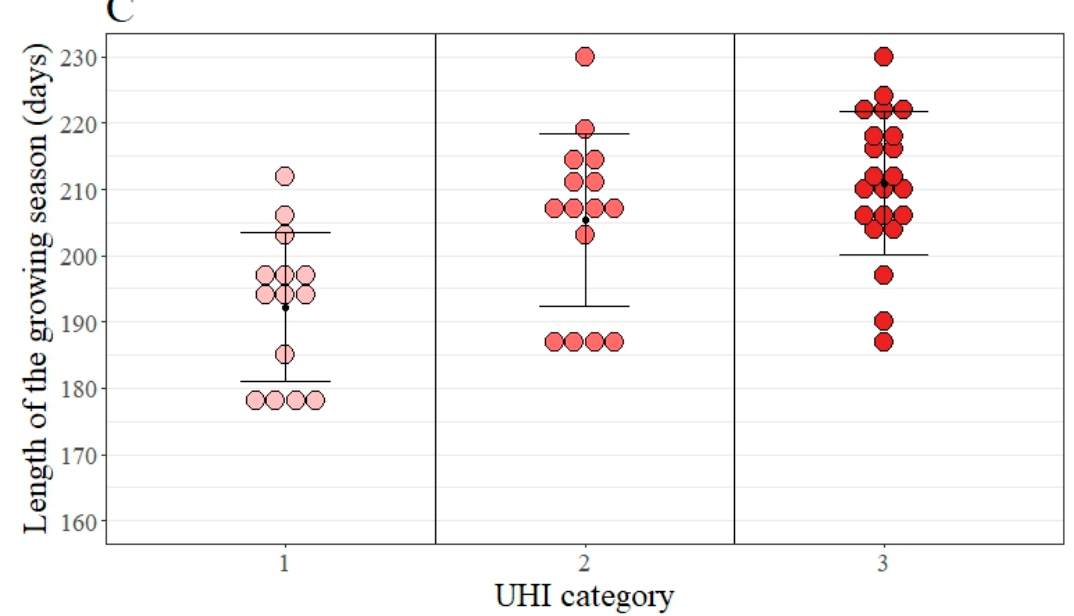
Figure 1. ( A ) The beginning of the bud break, ( B ) the length of the leaf discoloration, and ( C ) the length of the growing season of the investigated trees, separated by UHI intensity. The figure additionally shows the means and standard deviations.